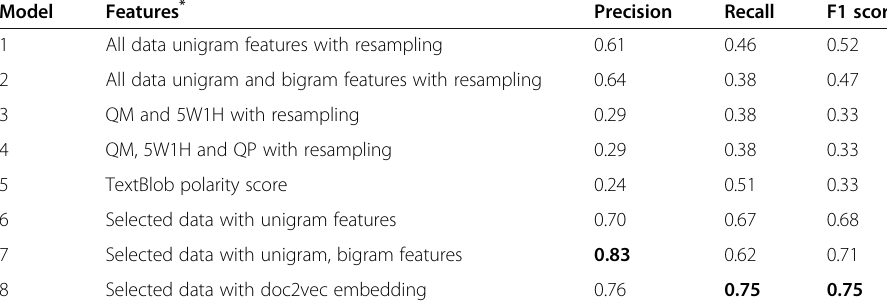
Table 3 Performance metric of LR models using various features